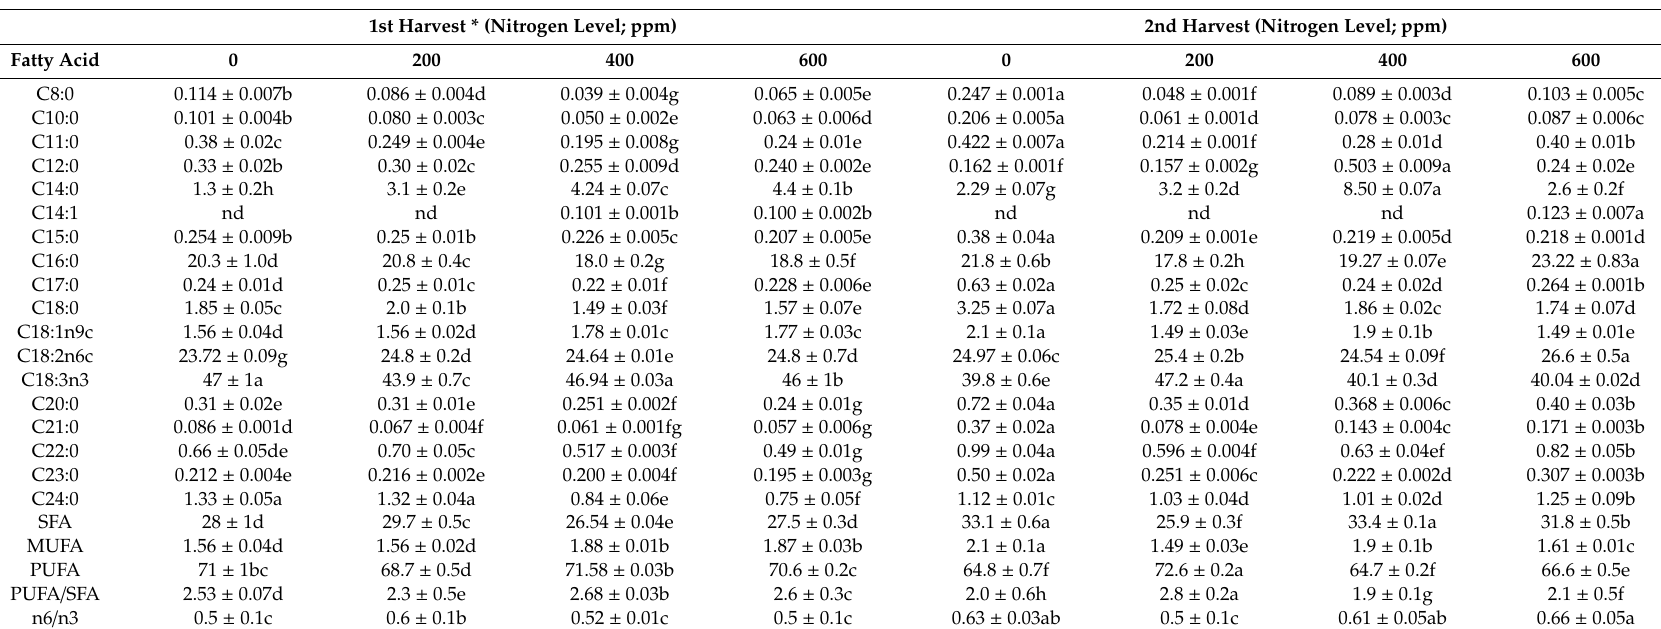
Table 6. Fatty acids composition (relative %) of Centaurea raphanina subsp. mixta plants grown in 2 L pots under greenhouse conditions, in relation to harvesting time (1st and 2nd harvest) and nitrogen level (0–600 ppm) (mean ±